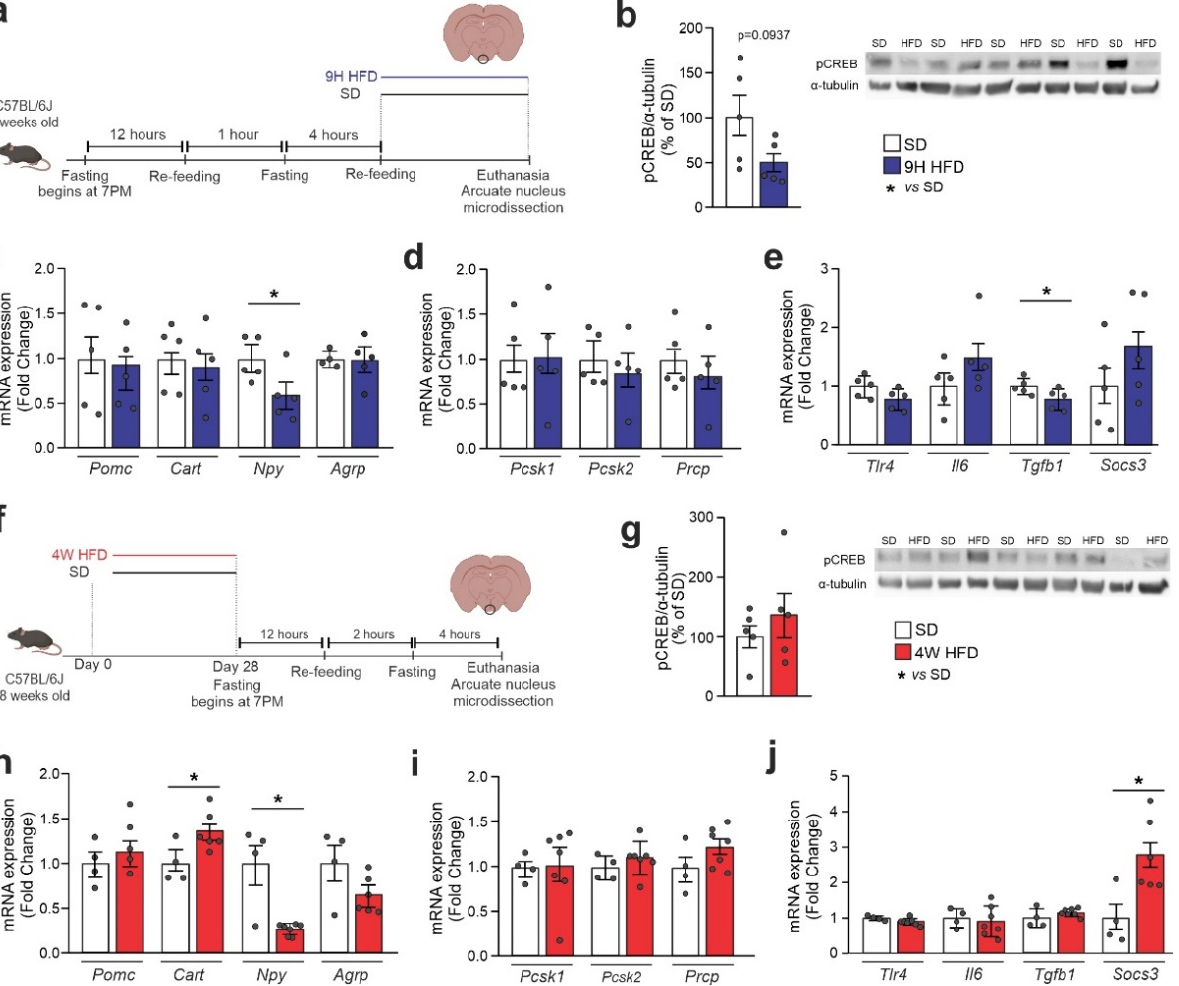
Figure 4. CREB ARC expression is modulated upon HFD. Adult male C57BL/6J mice were fed an HFD for chronic and acute periods and the arcuate nucleus (ARC) was microdissected. ( a ) Schematic representation of the experimental protocol of HFD-acute feeding; ( b ) Western blotting of the ARC after an acute period of HFD; ARC mRNA levels of ( c ) neuropeptides; ( d ) Pomc-related processing enzymes and ( e ) inflammatory markers. ( f ) Schematic representation of the experimental protocol of HFD-chronic feeding; ( g ) Western blotting of the ARC after a chronic period of HFD; ARC mRNA levels of ( h ) neuropeptides, ( i ) Pomc-related processing enzymes and ( j ) inflammatory markers. Data are presented as means ± SEM. We pooled ARC from three mice per sample. n = 5 per group. Student’s t -test was used for statistical analyses. * p ≤ 0.05 in comparison with the SD group.